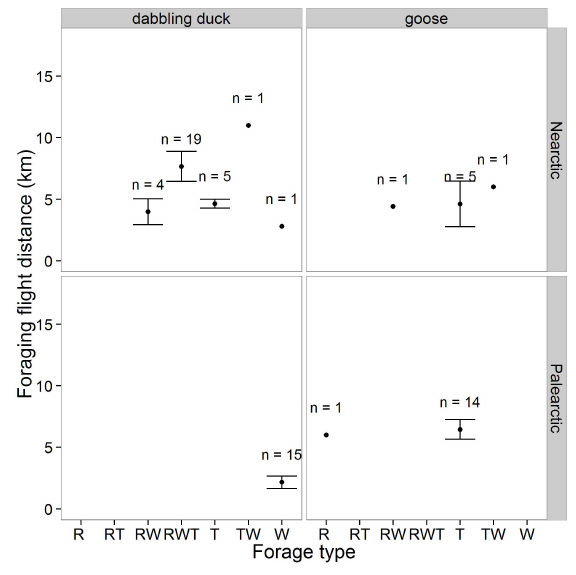
Fig. 1 . Mean foraging flight distance (km), standard errors, and sample sizes for wintering waterfowl by Guild (dabbling duck, goose), Location (Nearctic, Palearctic), and Forage Type (T = terrestrial, which included high marsh, pasture, grassland, or cropland other than rice [ Oryza sativa ]; W = wetland, and R =